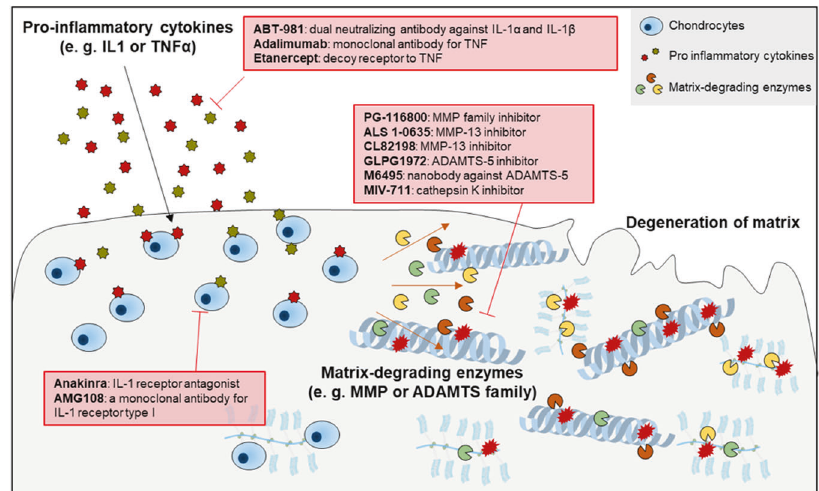
Fig. 1 Pharmacological management of OA by blocking pro-in fl ammatory cytokines and matrix-degrading enzymes. IL-1 and TNF are the major pro-in fl ammatory cytokines that stimulate the production of matrix-degrading enzymes and in fl ammatory mediators in joint tissues. MMP and ADAMTS family members degrade the extracellular matrix components of cartilage, promoting osteoarthritic cartilage